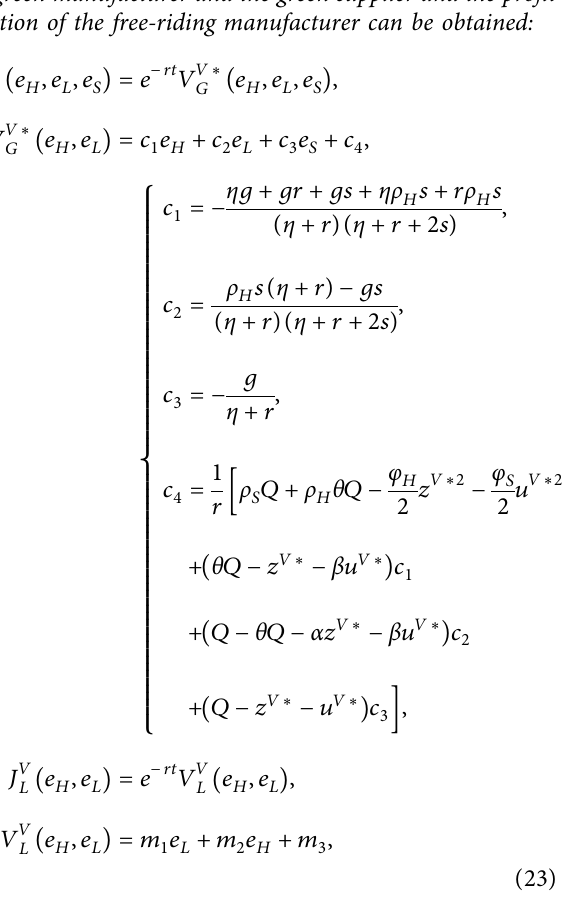
Green Manufacturers. Calculate the difference between green innovation efforts in two